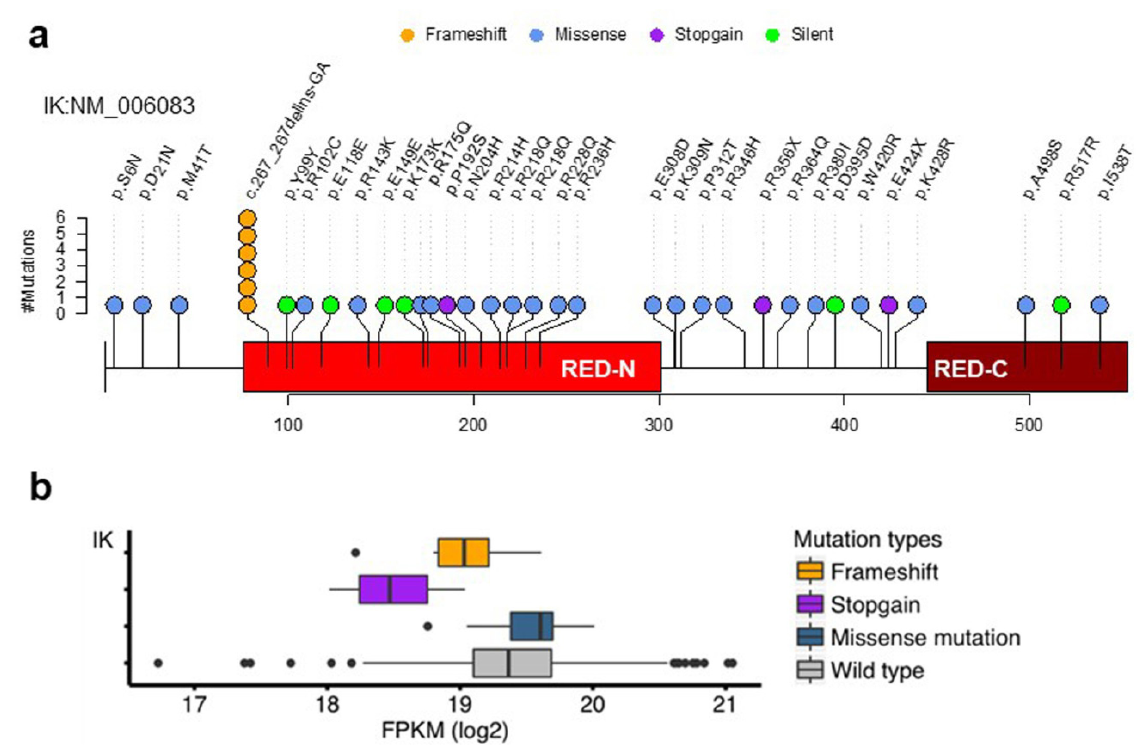
Figure 1. Somatic mutations of the IK gene in EEC. ( a ) IK somatic mutations. The plot was generated by OncoPrint in cBioPortal (https://www.cbioportal.org/ (accessed on 4 April 2017). ( b ) Comparison of gene expression between patients with somatic mutations of IK and those with wild-type IK . FPKM, fragments per kilobase of transcript per million mapped reads. p = 0.001, Student’s t test for frameshift and stop-gain mutations.